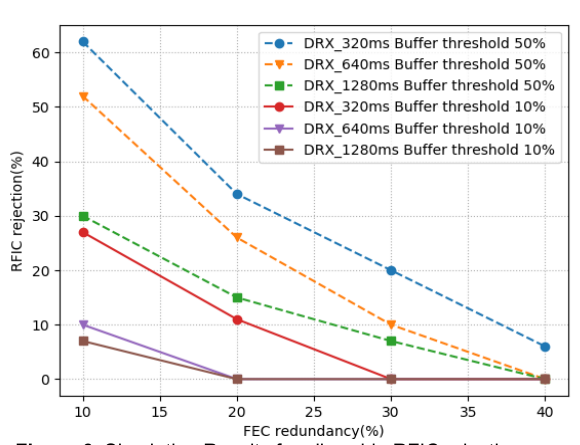
Figure 6. Simulation Results for allowable RFIC rejection as a function of FEC redundancy for MBMS video